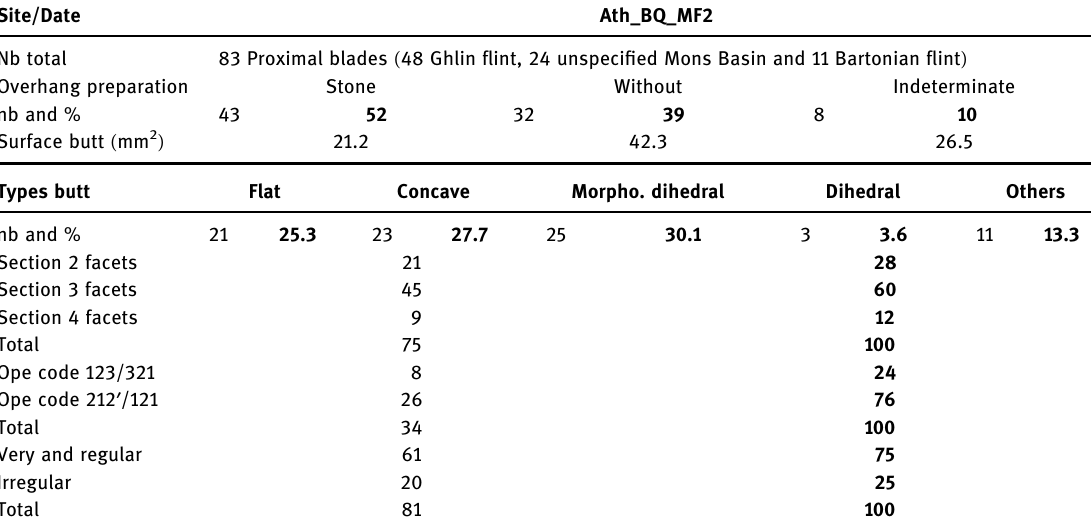
Table 7: Summary indicating the descriptive technical criteria of the blades attributed to MF2, at Ath “ les Haleurs, ” BQ settlement